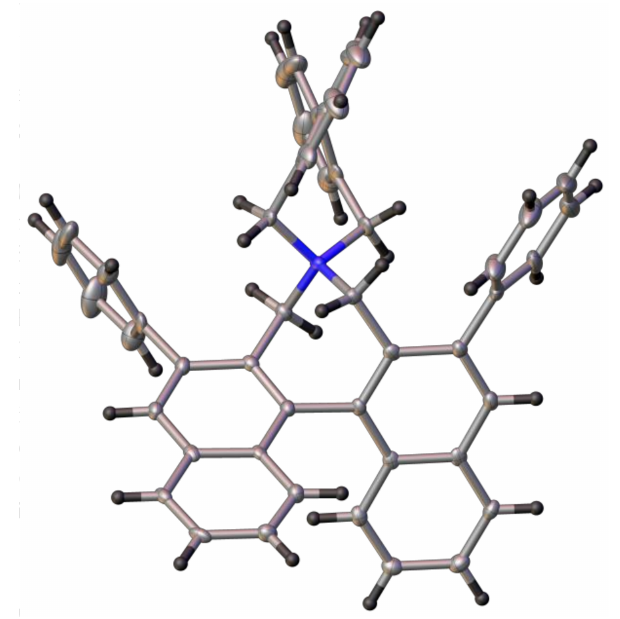
Figure 4. X-ray structure of 3a (counterion and solvent molecules